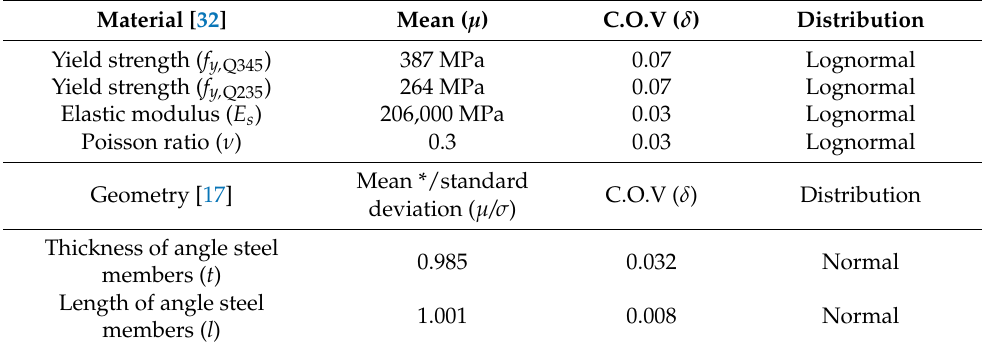
Table 2. Probabilistic features of structural